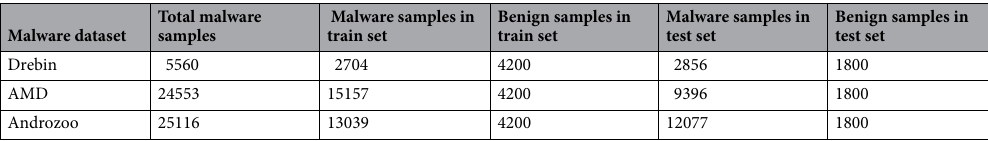
Table 6. Train and test set splits for classifiers trained on clones free train sets.